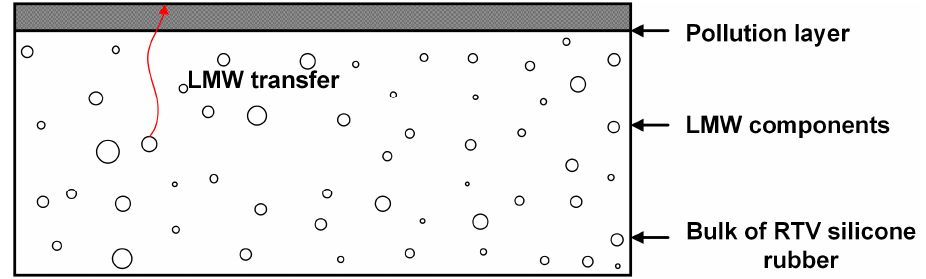
Figure 4. Transfer of LMW components from the bulk to the surface of the pollution layer [27].